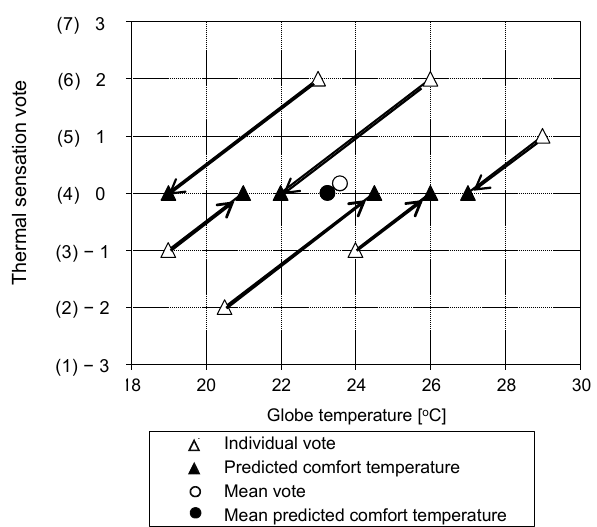
Figure 2. Griffiths method for regression coefficient of 0.5.